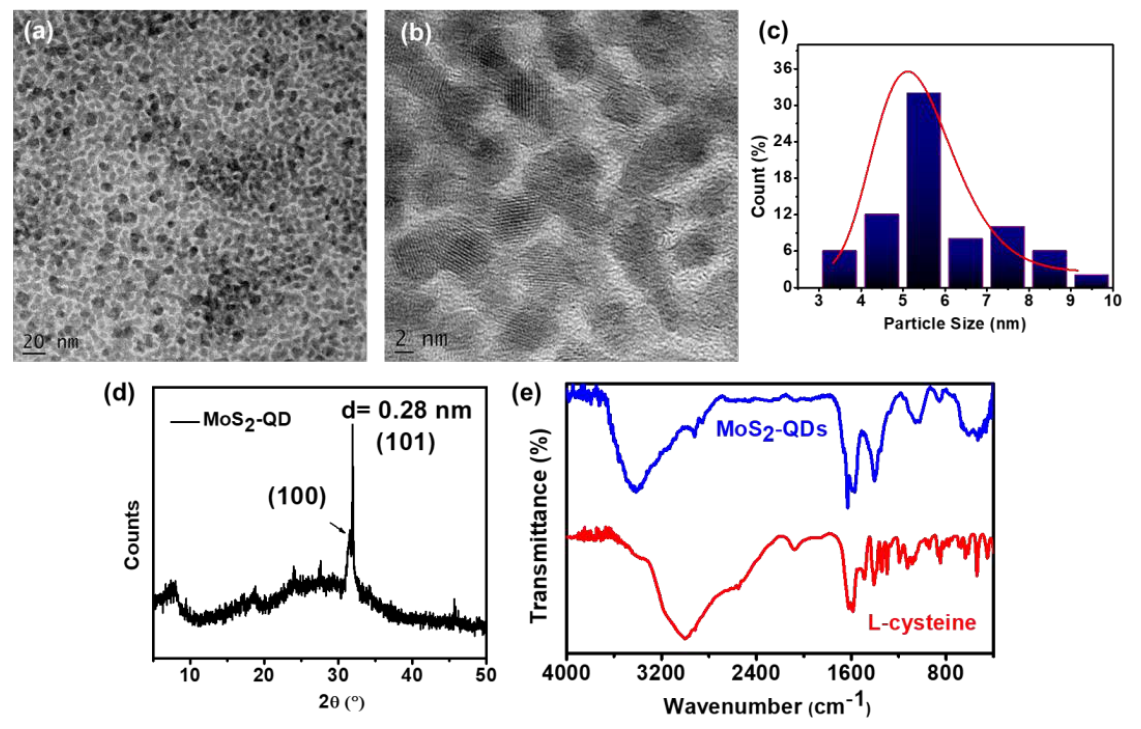
Figure 1. ( a ) TEM image of the MoS 2 − QDs, ( b ) high-resolution TEM image with lattice fringes. ( c ) The size distribution plot of the synthesized QDs derived from the TEM image. ( d ) Powder XRD study of MoS 2 − QDs. ( e ) FTIR spectra of L − cysteine and MoS 2 − QDs.